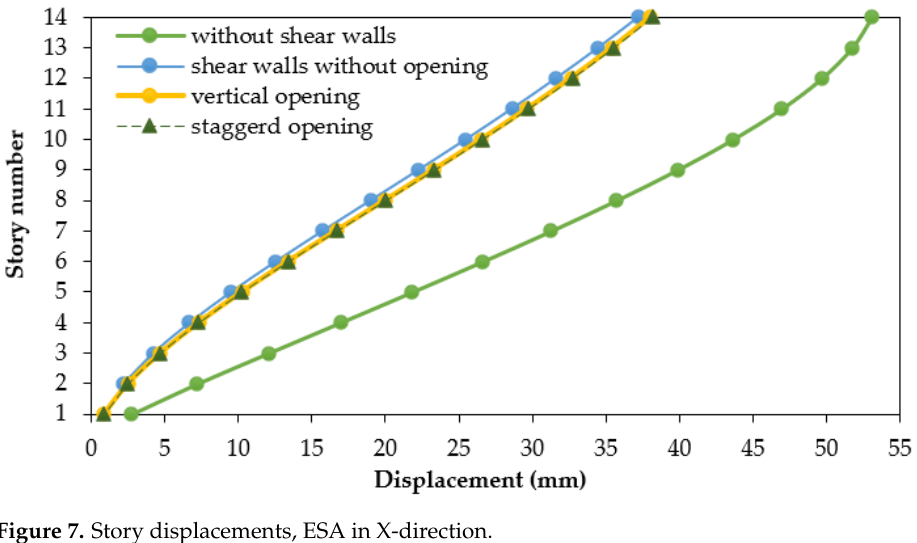
Figure 7. Story displacements, ESA in X-direction.